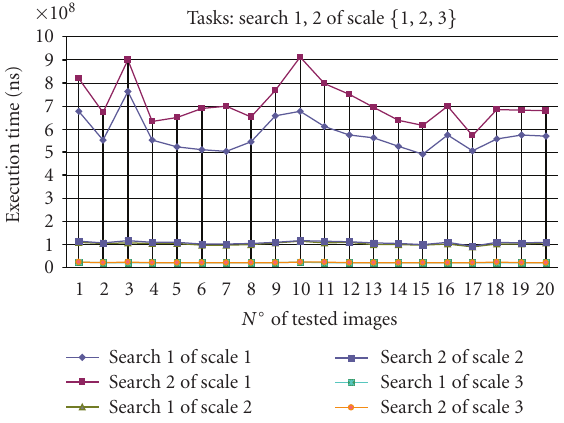
Figure 11: Execution time measurement of search task.